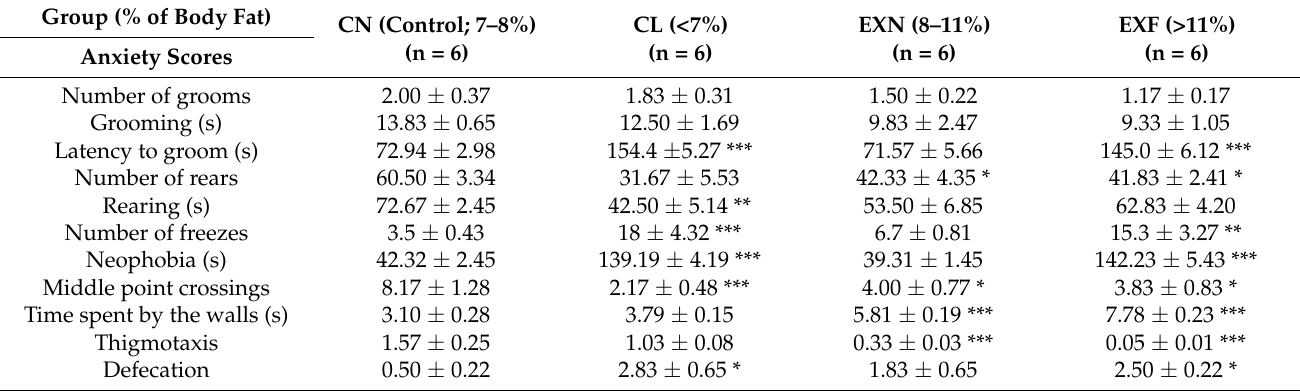
Table 7. Behavioral scores for anxiety-related behavior in mice with various body conditions. Abbre- viations: (CN) control group of mice characterized by normal weight and physiological percentage of body fat deposits; (CL) control group of mice characterized by reduced weight and reduced body fat deposits; (EXN) experimental group of mice characterized by normal weight and moderately elevated body fat deposits; (EXF) experimental group of mice characterized by markedly elevated weight and body fat deposits. Data are shown as mean ± SEM. Statistical significance of